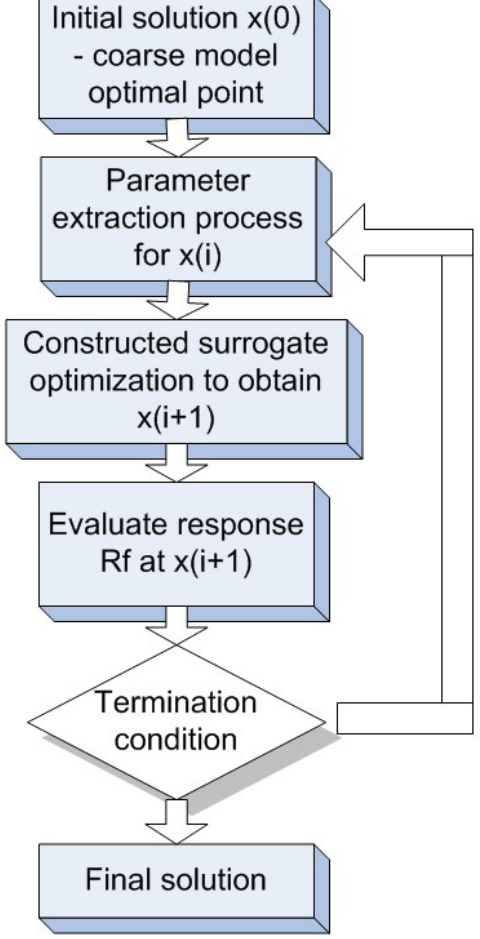
Figure 6. Flowchart of space mapping